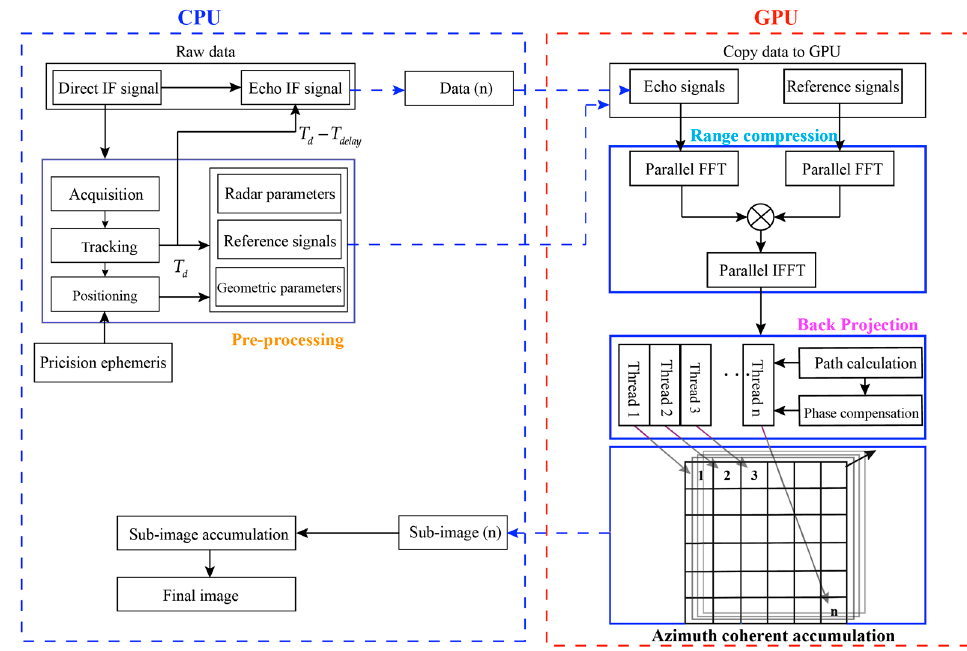
Figure 5. GNSS-R BSAR signal processing flowchart.